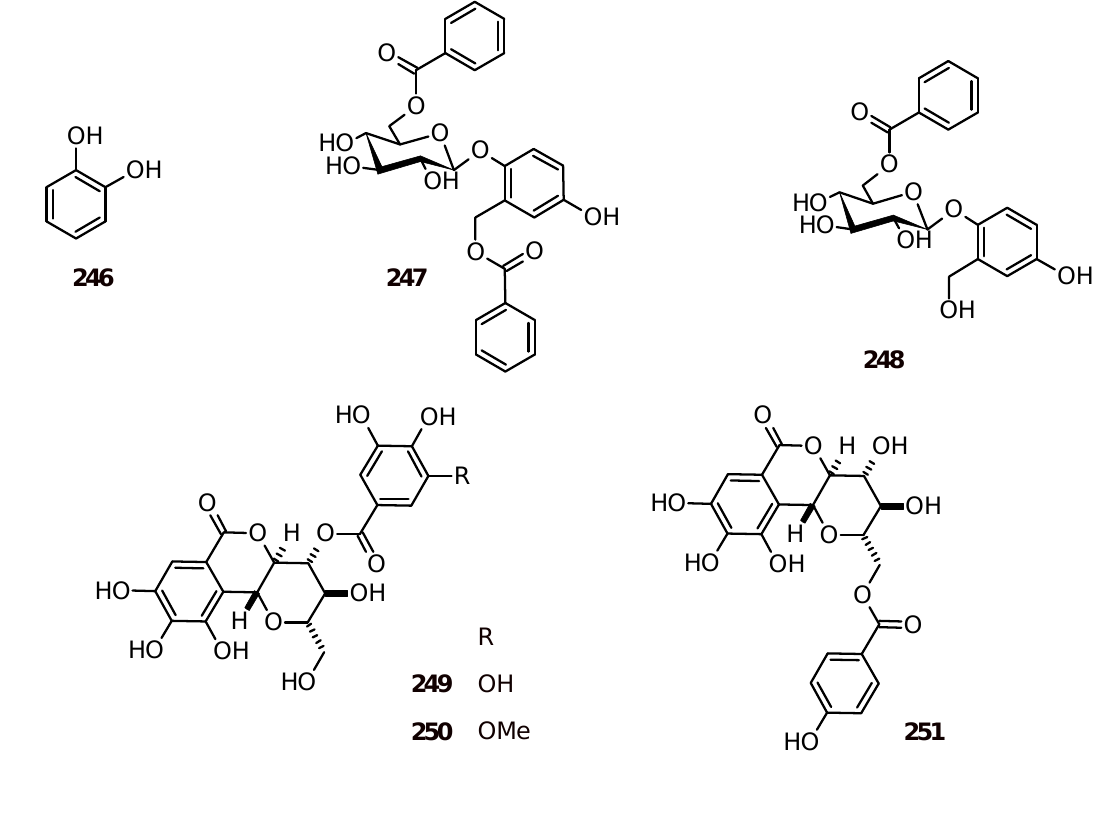
Figure 29. Structures of phenylmethanoids and phenolics 246 - 251 .